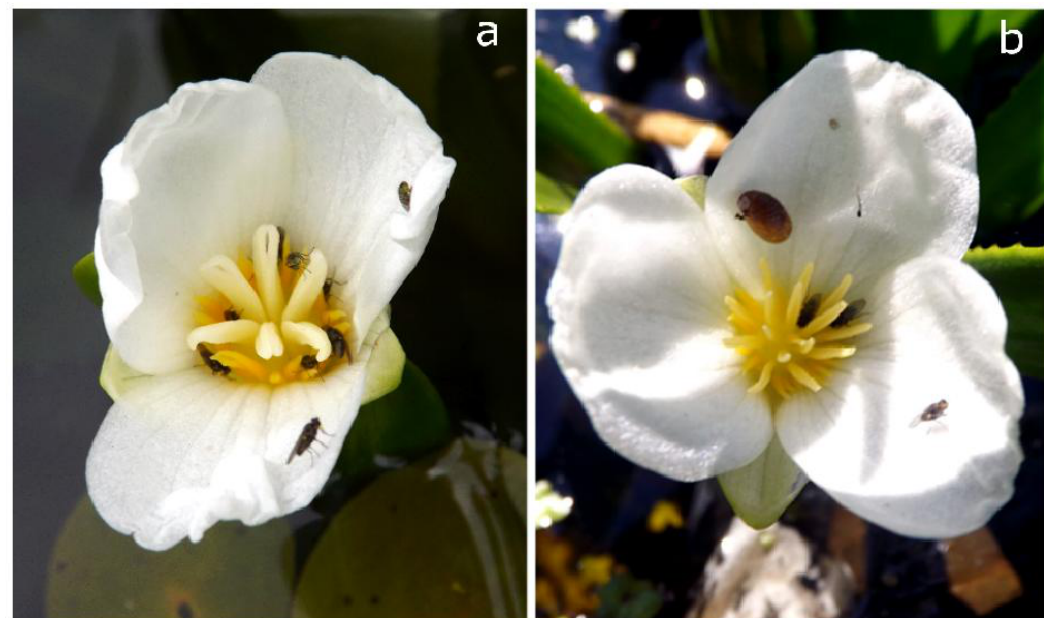
F IGURE 1. Hydrellia tarsata flower visitors on female (part “a”, sample 2014-1 see Tab. 1) and male (part “b”, sample 2014-3 see Tab. 1) flowers of Stratiotes aloides. Note the forked, yellow nectaries clustered around regenerative organs offering nectar reward for flower visitors and H. tarsata in contact with flower stigmata and